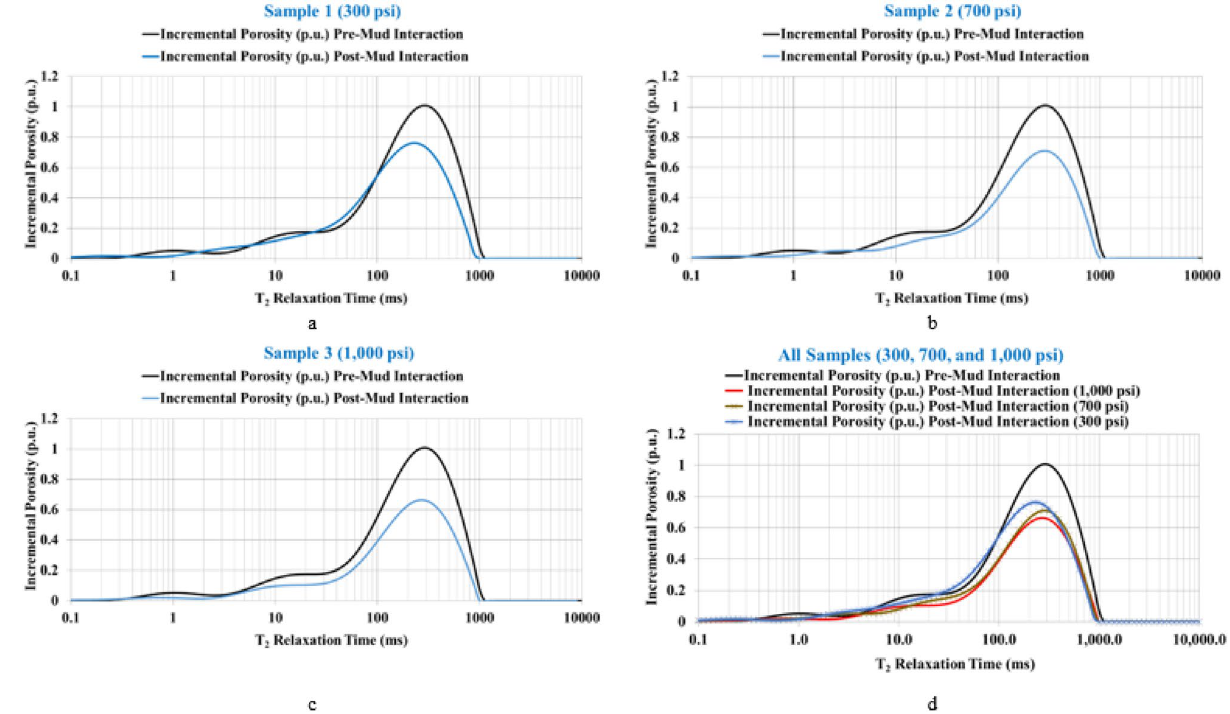
Figure 4. The incremental porosity plots with the overbalance pressure. ( a ) Under 300 psi overbalance. ( b ) Under 700 psi overbalance. ( c ) Under 1000 psi overbalance. ( d ) all samples.